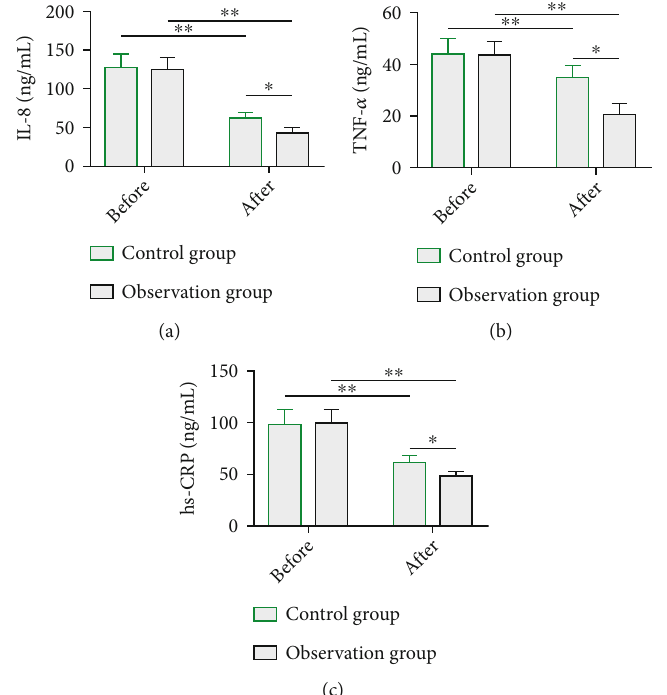
Figure 3: In fl ammation indexes in the two groups. (a) After therapy, IL-8 in the observation group decreased statistically, which was lower than that in the control group. (b) After therapy, TNF- α in the observation group decreased statistically, which was lower than that in the control group. (c) After therapy, hs-CRP in the observation group decreased statistically, which was lower than that in the control group.